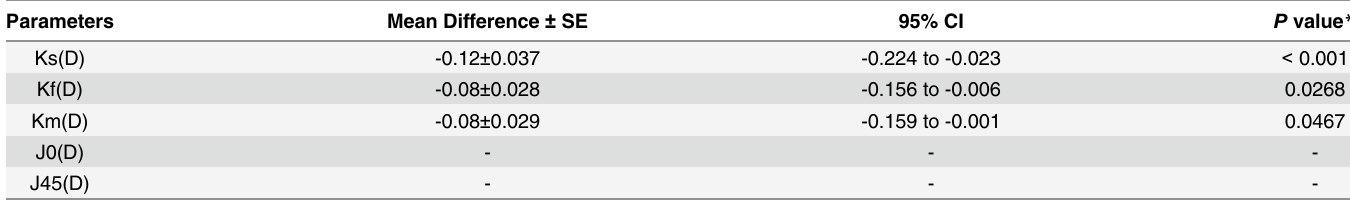
Table 8. Comparison of Ks, Kf and Km obtained by Topcon KR-1W and Topolyzer. (Note: Ks: steep keratometry, Kf: flat keratometry, Km: mean kerato- metry, D: diopter, SD: standard Error, 95% CI: 95% consistent interval, * Bonferroni corrected.)